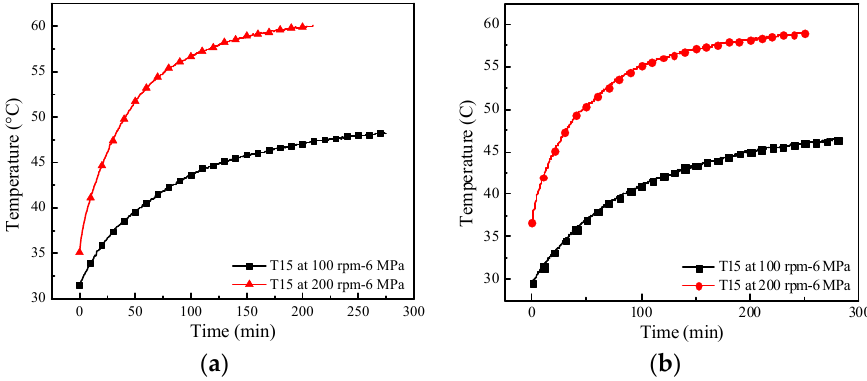
Figure 7. Comparison of temperature under the same load and at different speeds. ( a ) S220; ( b ) M220.